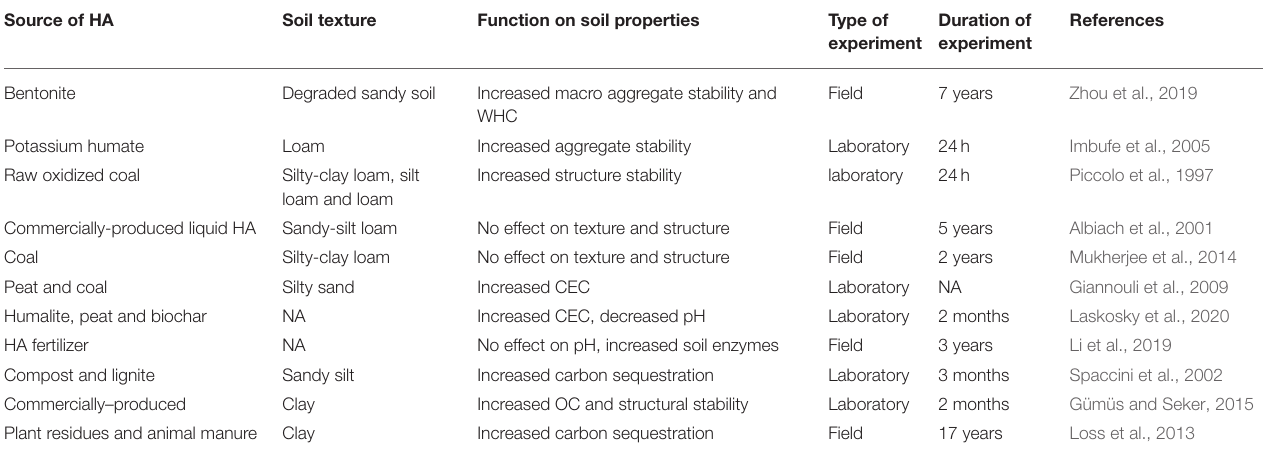
TABLE 1 | Summary of humic acids on soil